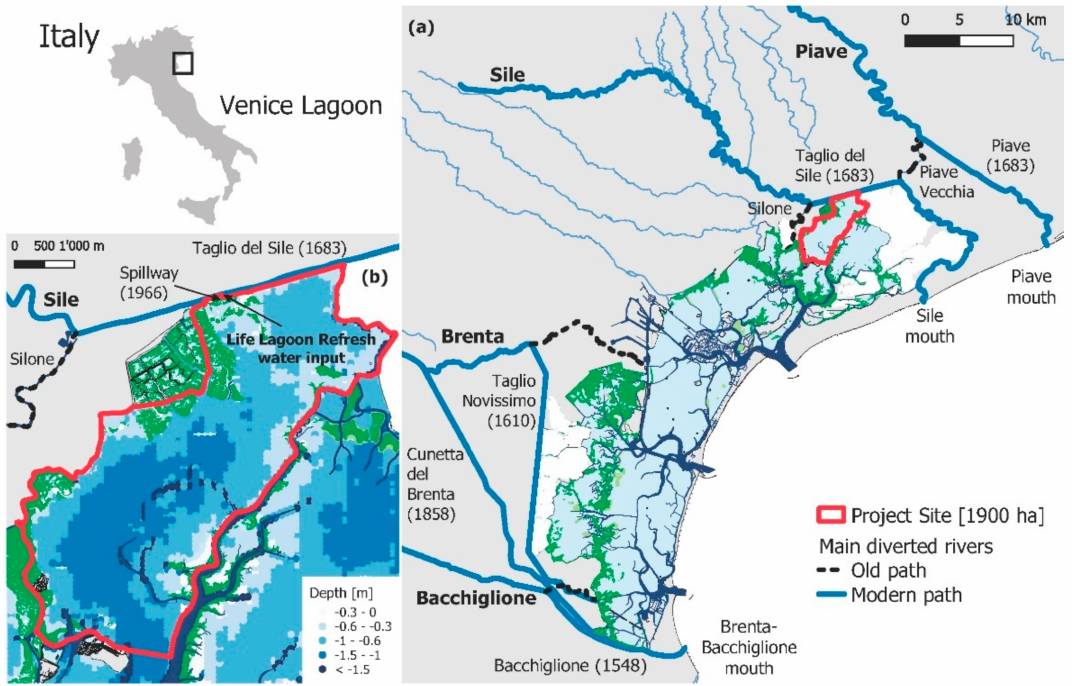
Figure 1. ( a ) A map of the Venice Lagoon with main rivers (Bacchiglione and Brenta in the south, Sile and Piave in the north) diverted during historical human environmental modifications